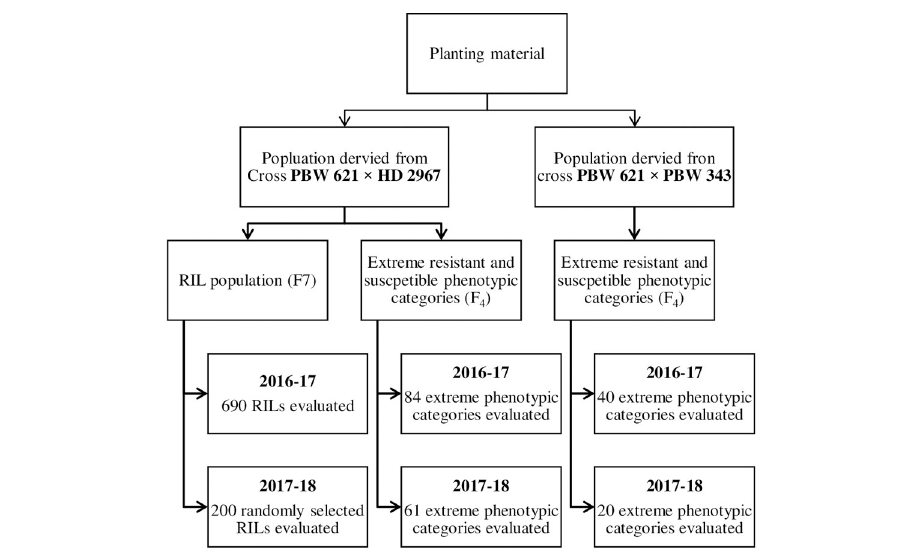
Fig 1. Details of planting